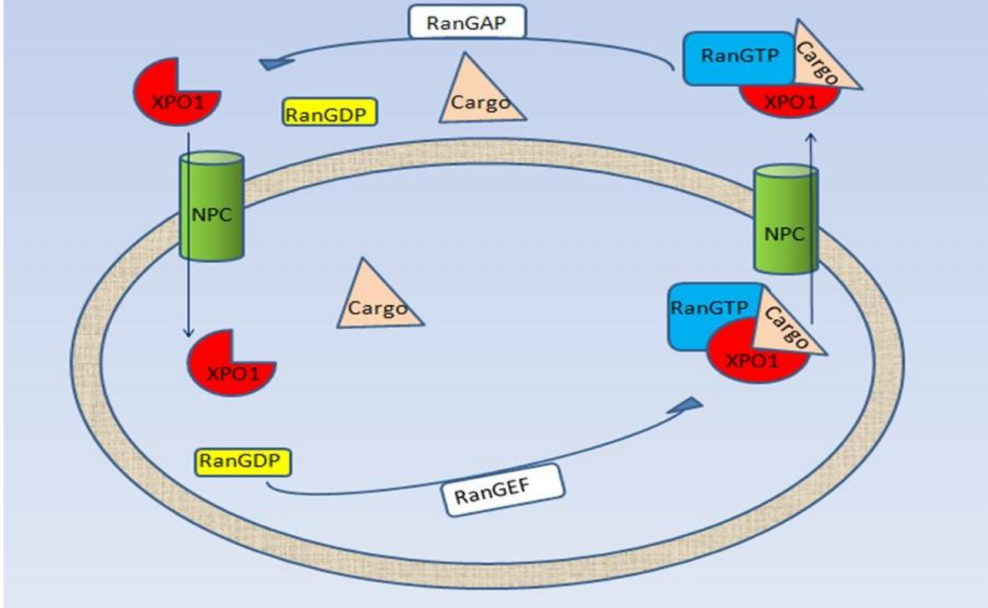
Figure 1. Schematic representation of the nucleocytoplasmic transport. The NPC * is composed by a complex structure of multiple rings. Cargo proteins (pink triangles in this figure) carriy an NES * bind to XPO1 * (red oval shapes in the figure) and RanGTP * (blue rectangles) through NPC (green cylinders). In the cytoplasm, hydrolysis of RanGTP to RanGDP * (by RanGAP *) allows complex dissociation. At this point, XPO1 can move back to the nucleus through NPC and the process resumes. * NPC: Nuclear Pore Complex; NES: Nuclear Export Signal; XPO1: Exportin-1; RanGTP: Ras-related Nuclear protein binding Guanosine 5 (cid:48) -TriPhosphate; RanGDP: Ras-related Nuclear protein binding Guanosine 5 (cid:48) -DiPhosphate; RanGAP: Ran-GTPase Activating